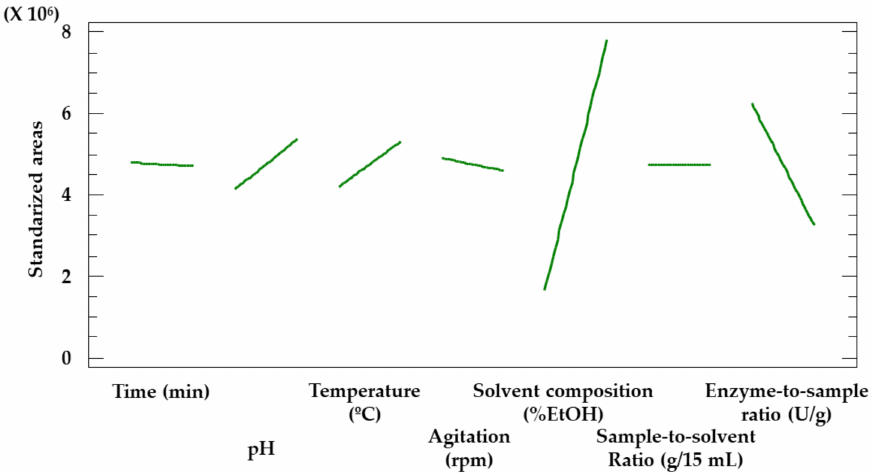
Figure 3. Plot representing the main effects of the 7 factors screened by the Placket–Burman design. Given that agitation, sample-to-solvent ratio or time did not prove to be significant factors, the values to be established for further analysis were determined according to whether their effect on the extraction yield was positive (sample-to-solvent ratio) or negative (agitation and time). Therefore, 50 rpm, 0.2 g/15 mL and 10 min were established as the values to be used for the Box–Behnken design extractions.